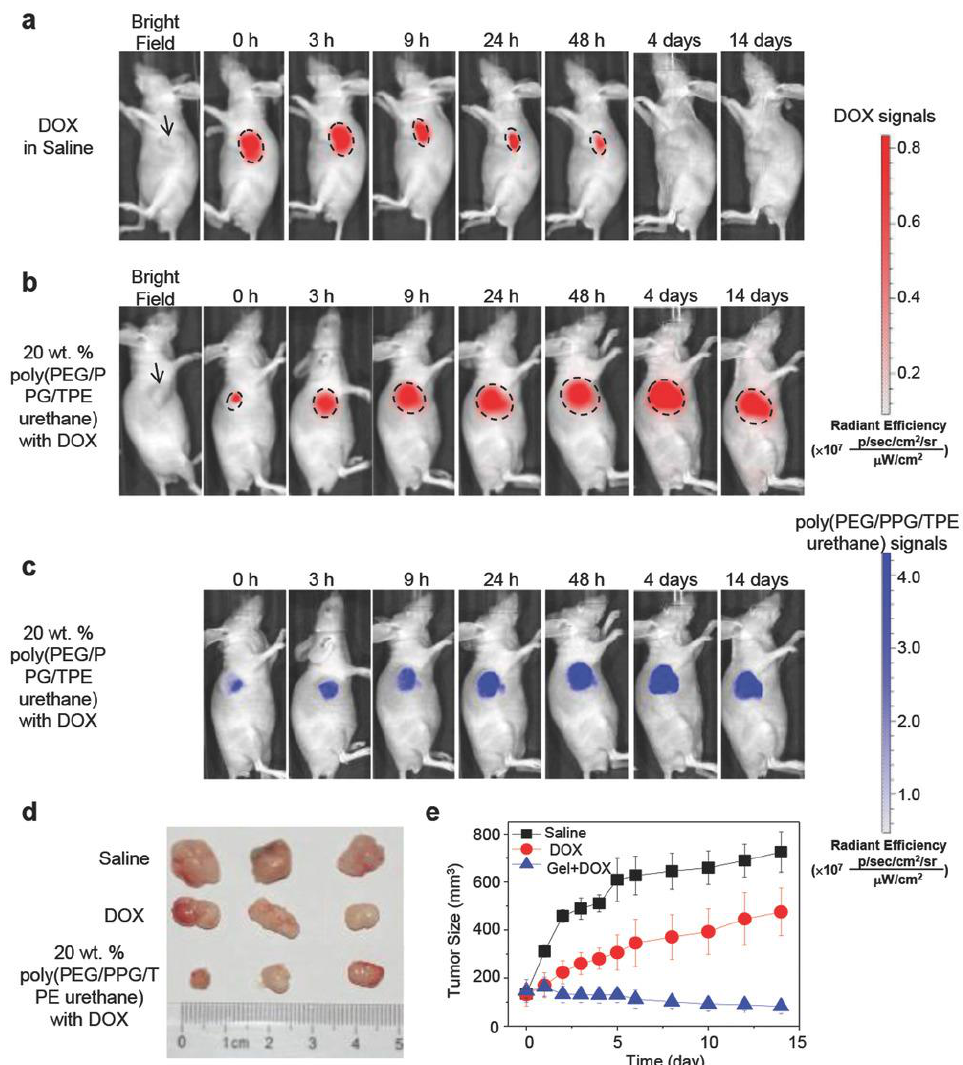
Figure 21. In vivo mouse model. ( a – c ) In vivo noninvasive fluorescence imaging of nude mice bearing HepG2 tumor with postintratumoral injection of 50 µL DOX in saline or DOX loaded thermogel for indicated time points. The black arrow indicated the location of the tumor. ( d,e ) Inhibition of tumor volume by intratumoral injection of saline, DOX, or DOX loaded EPT thermogels. Dorsal subcutaneous implantation of HepG2 cancer cells into mice was followed by administration of each solution after tumors had reached a volume of ~150 mm 3 . The excised tumor removed after 14 d was taken for evaluation. Reproduced with permission from Reference [156]. Copyright 2016, John Wiley and Sons.